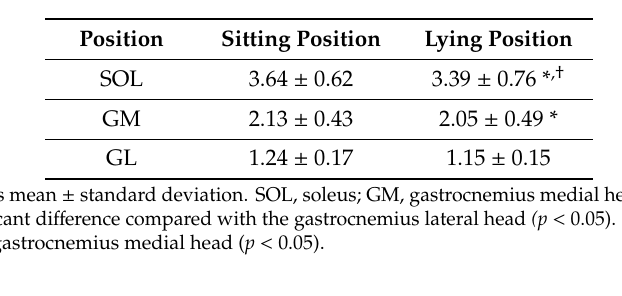
Table 3. Muscle volume of each muscle (cm 3